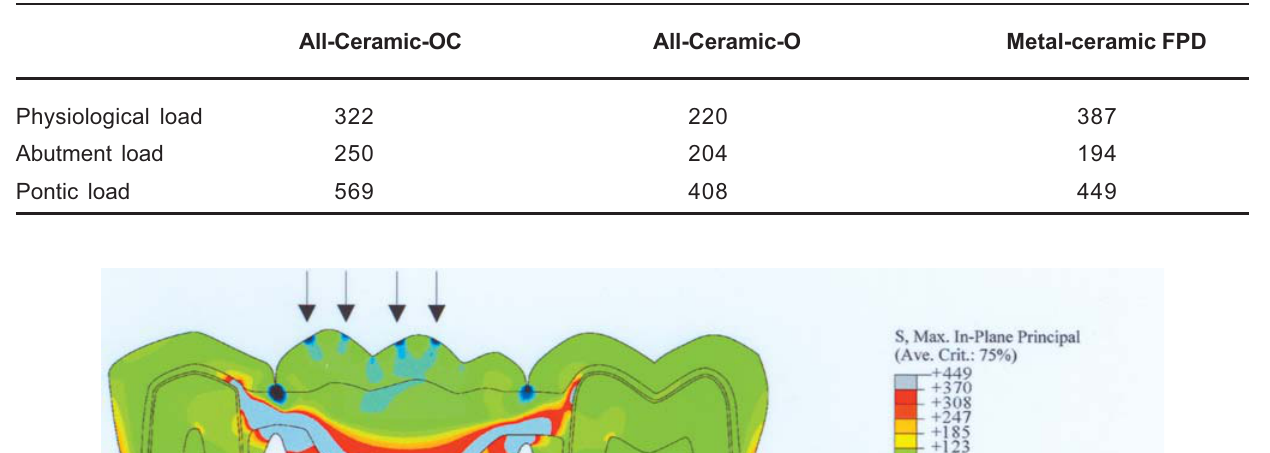
TABLE 2- Maximum stress values for each model with different loading